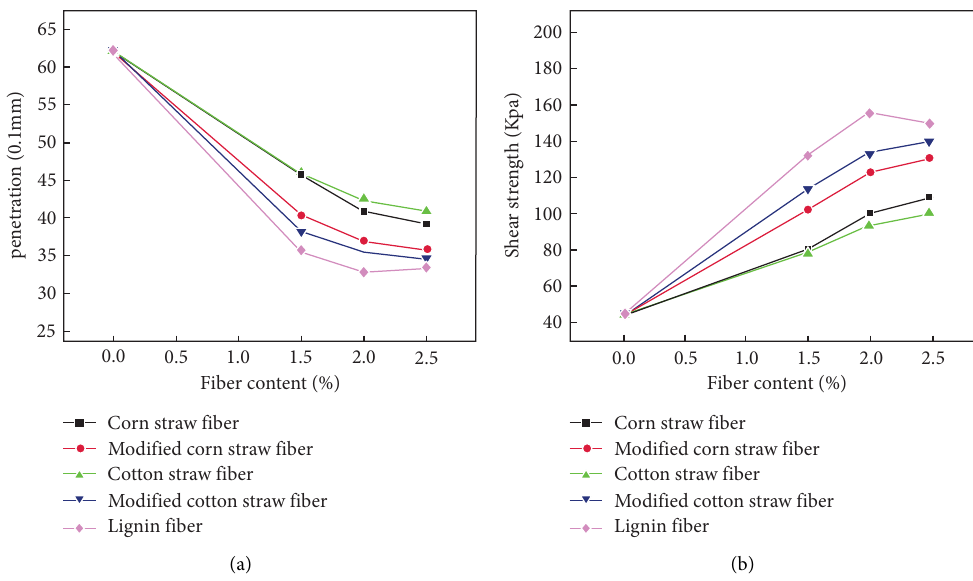
Figure 5: Efect of fber content on (a) penetration and (b) shear strength of asphalt binder.